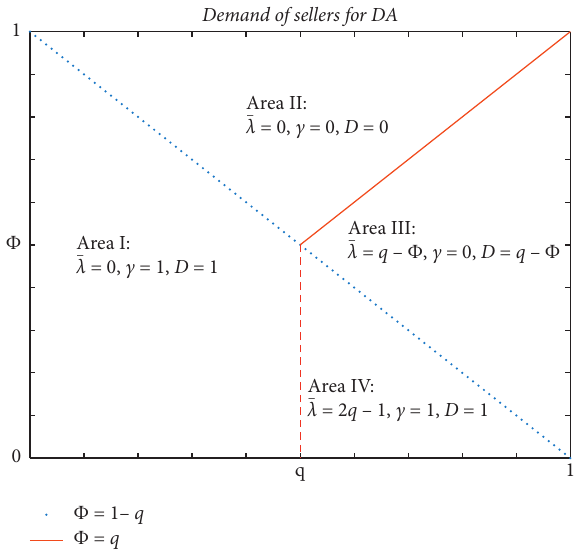
Figure 2: The impact of application fee and certification accuracy on the seller’s demand for